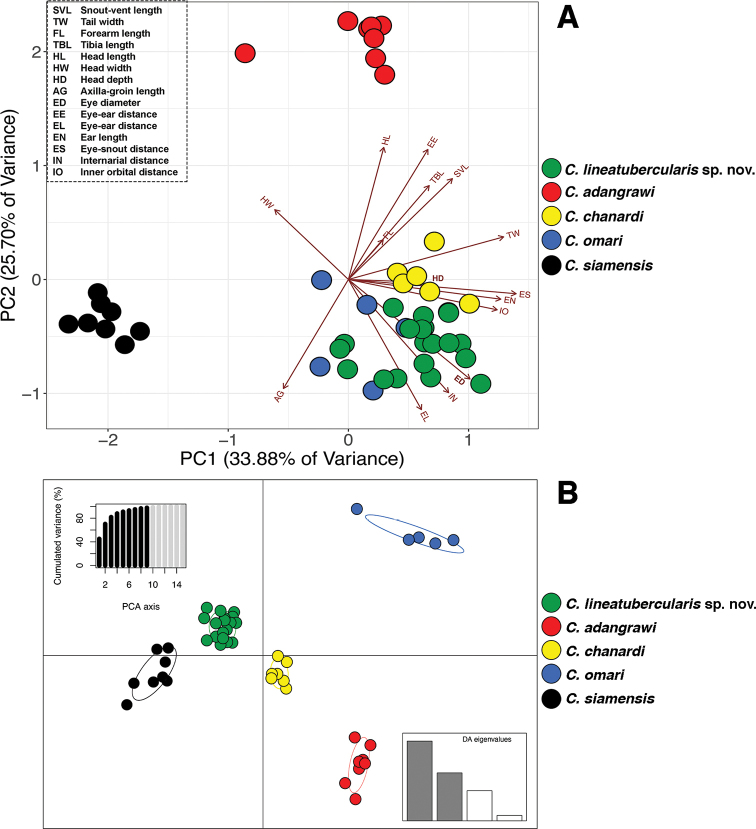
Results of principal component analysis (PCA), and clustering by discriminant function of principal component analysis (DAPC) of 15 morphological variables for 47 individuals of five Cnemaspis species (C.
lineatubercularis sp. nov., C.
adangrawi, C.
chanardi, C.
omari, and C.
siamensis) APCA scatter plot of PC1 and PC2 showing morphometric differentiation among five species in the siamensis group BDAPC ordination of all samples showing interspecific variation among five species in the siamensis group.